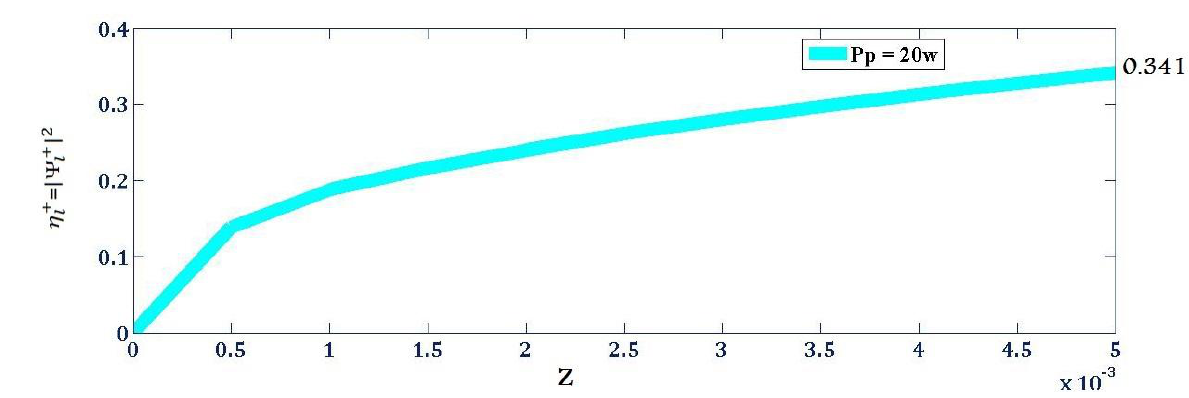
Figure 4. Output efficacy of forward laser beam along z direction (path length).